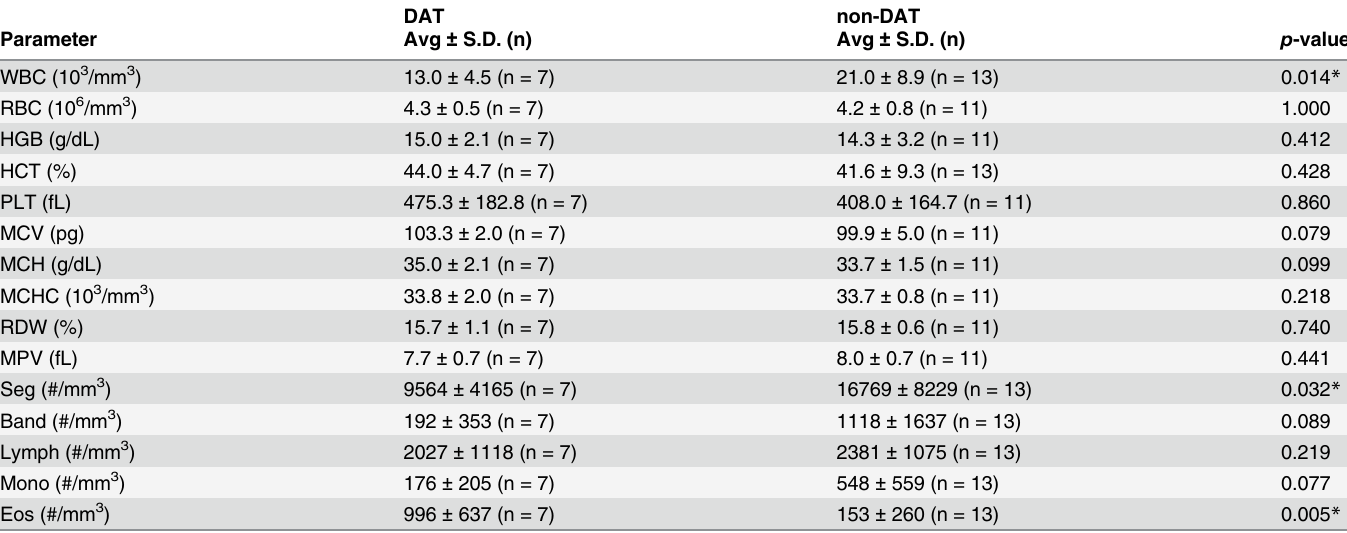
Table 6. Hematological parameters of the test set.